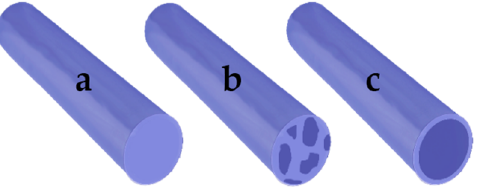
Figure 3. Types of electrospun fiber: ( a ) simple; ( b ) blend; ( c ) core-shell. Simple fibers: these are the most basic type of electrospun fiber. The fiber consists of intrinsic characteristics. Only one publication [48] using this type of fiber was identified in this review.